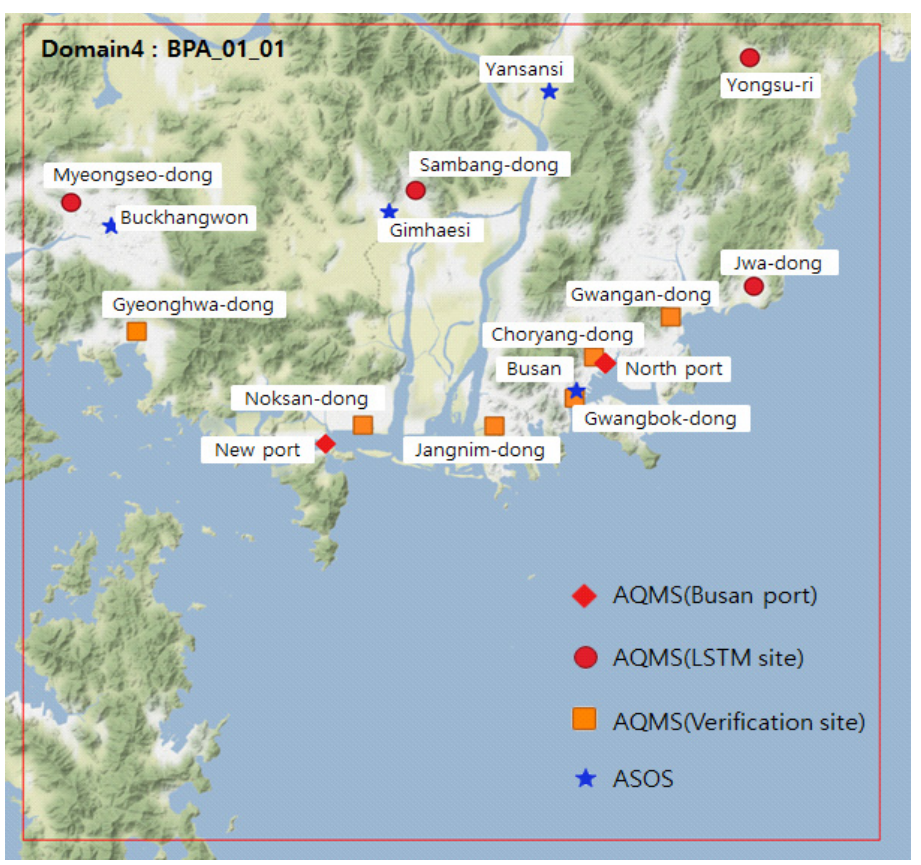
Figure 3. Locations of Air Quality Monitoring System (AQMS) sites and the Korea Meteorological Administration (KMA) Automated Synoptic Observing System (ASOS) sites in the research